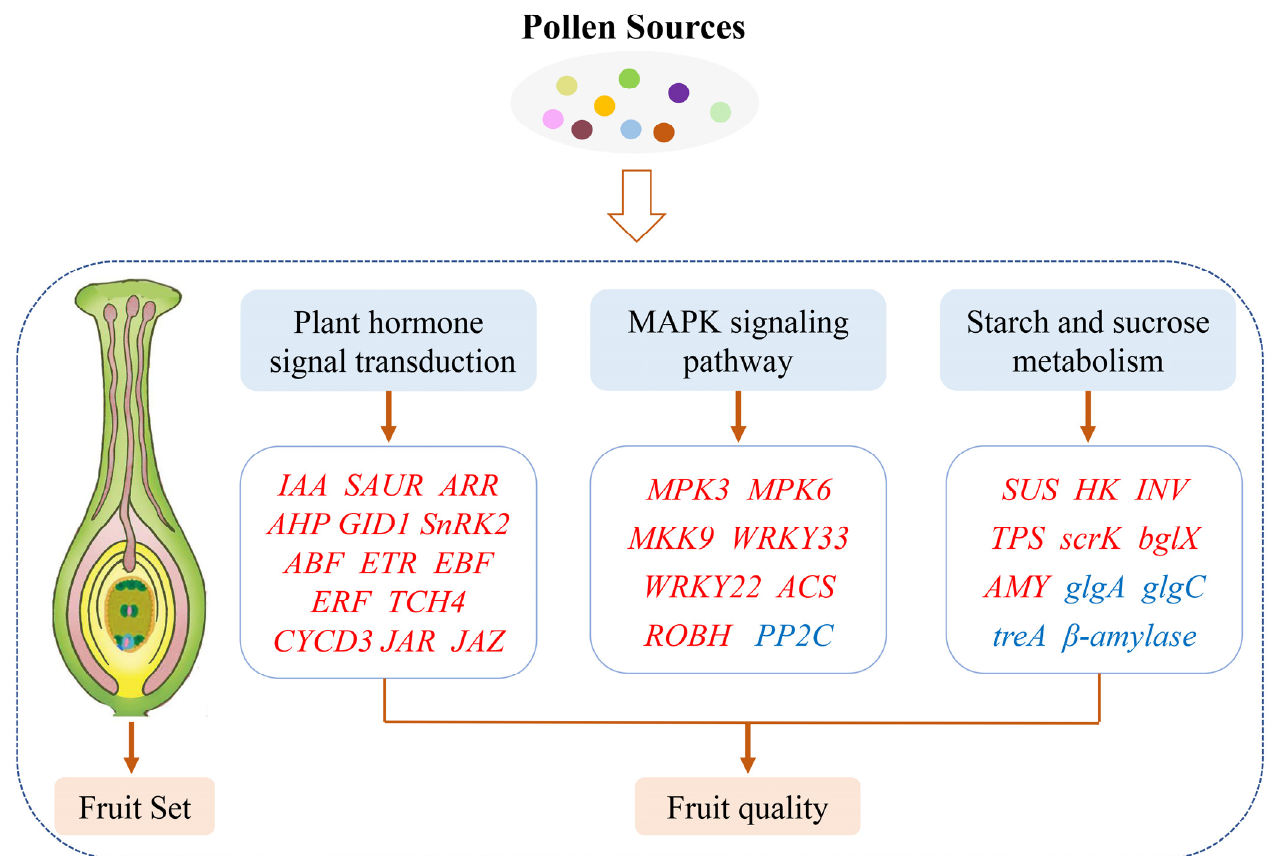
Figure 9. Physiological and molecular mechanisms by which different pollen sources affect fruit set and fruit quality in ‘Fengtangli’ plum. Red and blue colors indicate up- and down-regulation of gene expression in ‘Siyueli’-pollinated fruits,